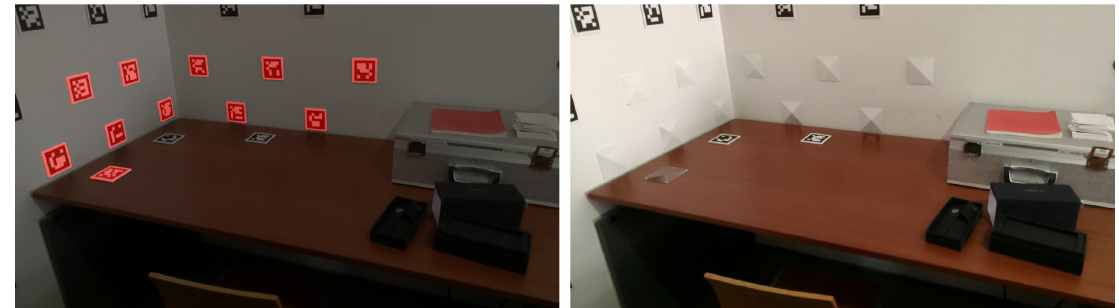
Figure 8. Example dataset image inpainting: ( left ) mask used for marker removal; ( right ) results of Navier-Stokes-based inpainting from OpenCV